Question: What visual encoding does this figure use to show its data?
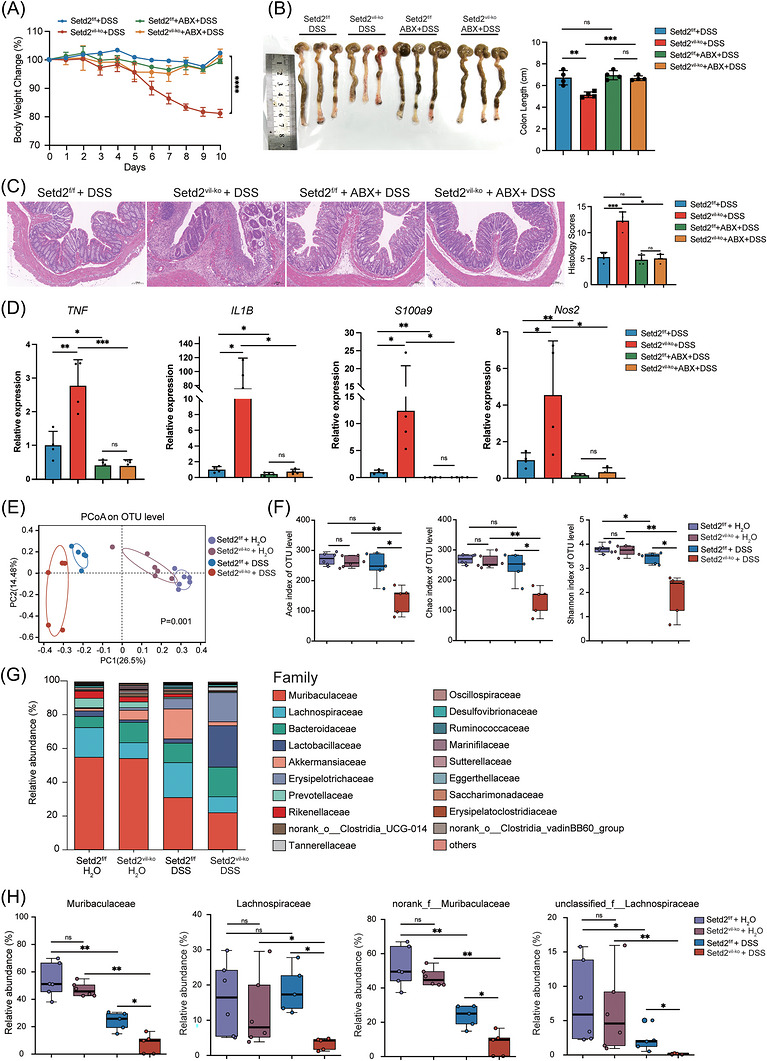
Answer: line